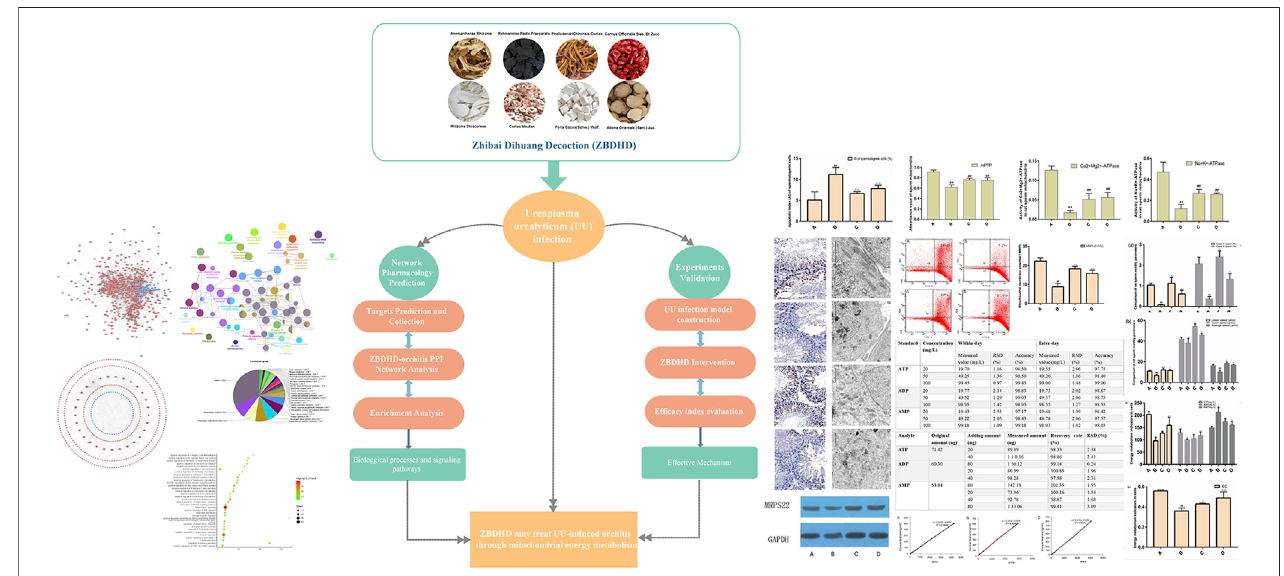
FIGURE 1 | Flow chart of this